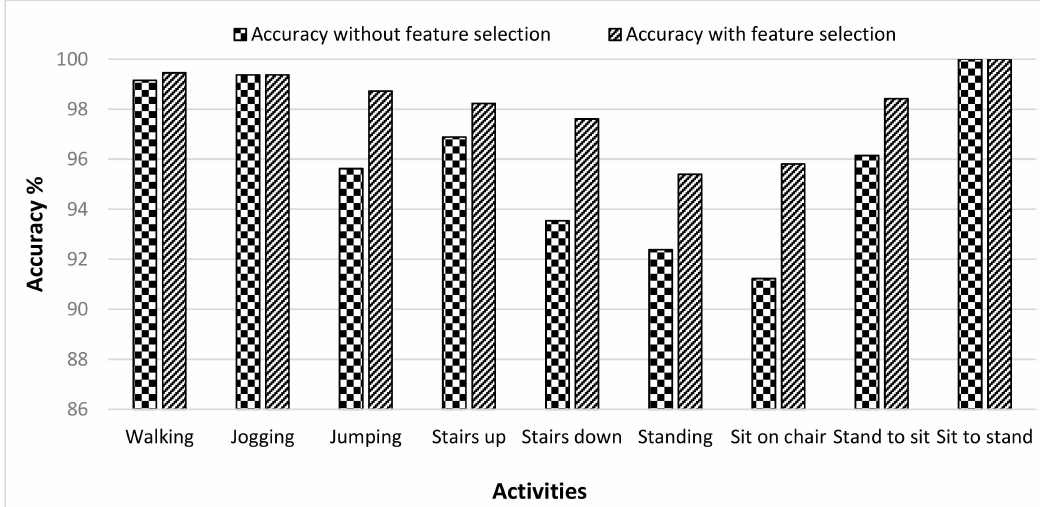
Figure 5. Comparison of recognition accuracies obtained by RF classifier for MobiAct dataset with and without feature